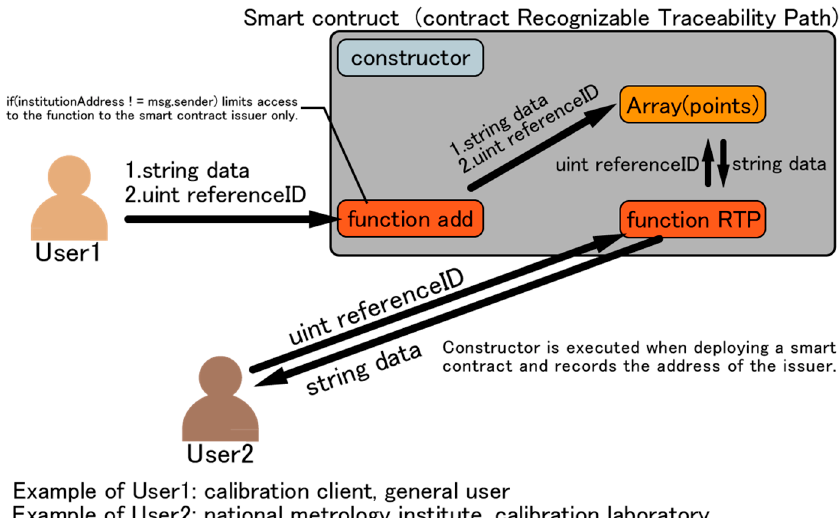
Figure 3. Overview of smart contract on RTP in this study. “function add” records the two arguments, “string data” and “uint referenceID”,